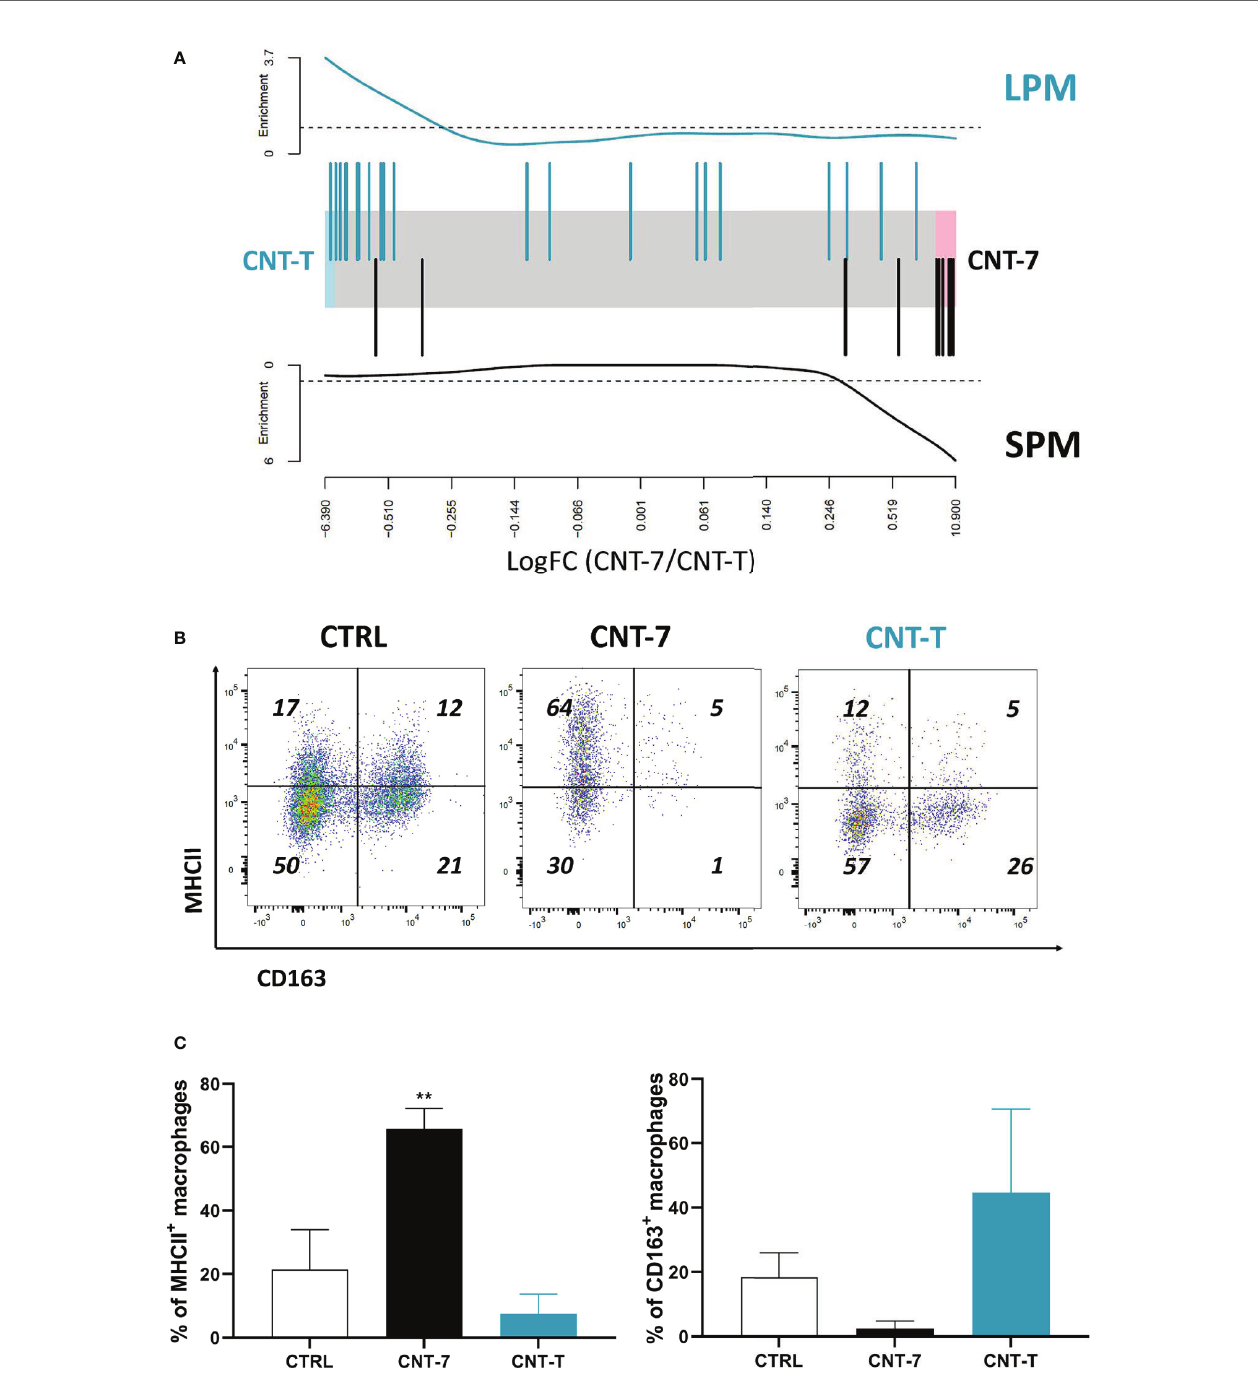
FIGURE 3 | Mesotheliomagenic CNT-7 and non-mesotheliomagenic CNT-T exposure induces MHCII high SPM and MHCII low LPM macrophage development, respectively. (A) Barcode plot showing enrichment of MHCII low (LPM-like) (in green, top panel) and MHCII high (SPM-like) (in black, bottom panel) signatures in the CNT-7 vs CNT-T macrophage comparison. Macrophages were puri fi ed from the peritoneal cavity of rats treated with CNT-7 or CNT-T (2 mg I.P.) and sacri fi ced after 15 days. Black bars show up MHCII high signature genes, blue bars show up MHCII low signature genes. The worms show relative enrichment. (B) Flow cytometry dot plots (MHCII-CD163) of CD11bc high and HIS48 dim macrophages from untreated and CNT-7- or CNT-T-treated Wistar rats (2 mg, I.P.) at 7 days. (C) Percentage of MHCII and CD163-positive macrophages from untreated or CNT-7/CNT-T-treated rats sacri fi ced 7 days after. Each bar represents the mean of 3 replicates ± SD. The results were statistically analysed using ANOVA test followed by Dunnett ’ s test. (**) p = 0.0021 indicates a statistically signi fi cant difference with